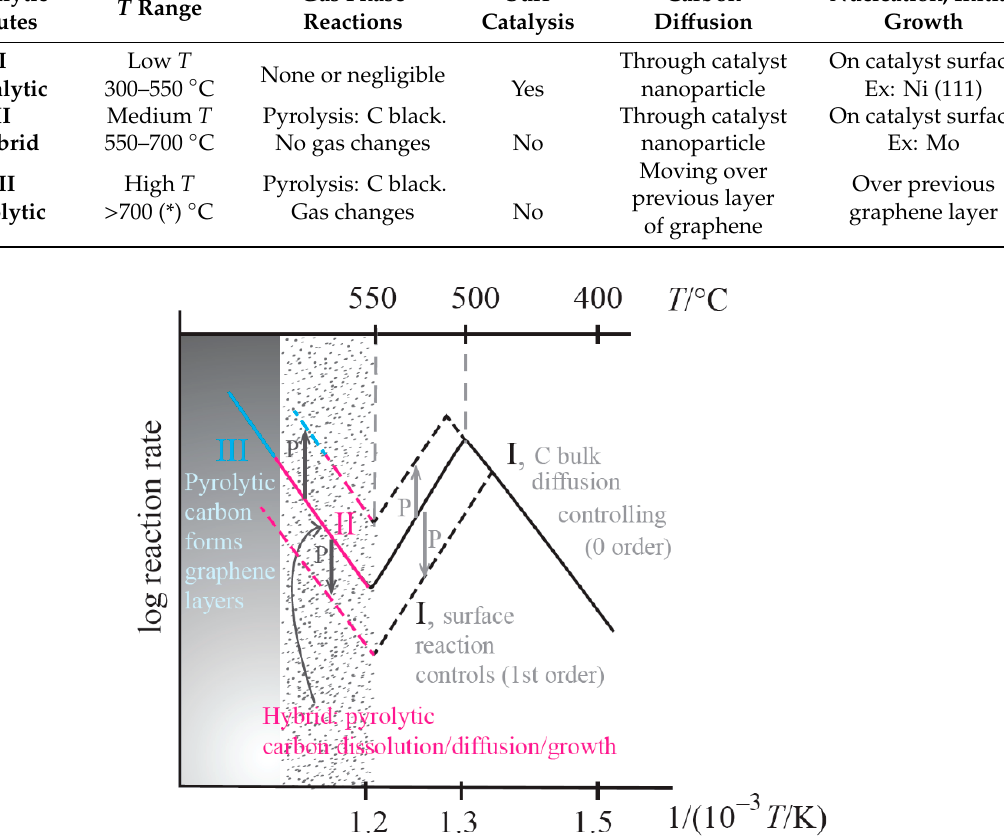
Figure 1. Arrhenius plots record showing three catalytic alternative routes operating in a carbon formation from hydrocarbons. Reaction orders indicated. Left side is colored grey to show the gas phase pirolytic carbon formed at T > 625 °C.